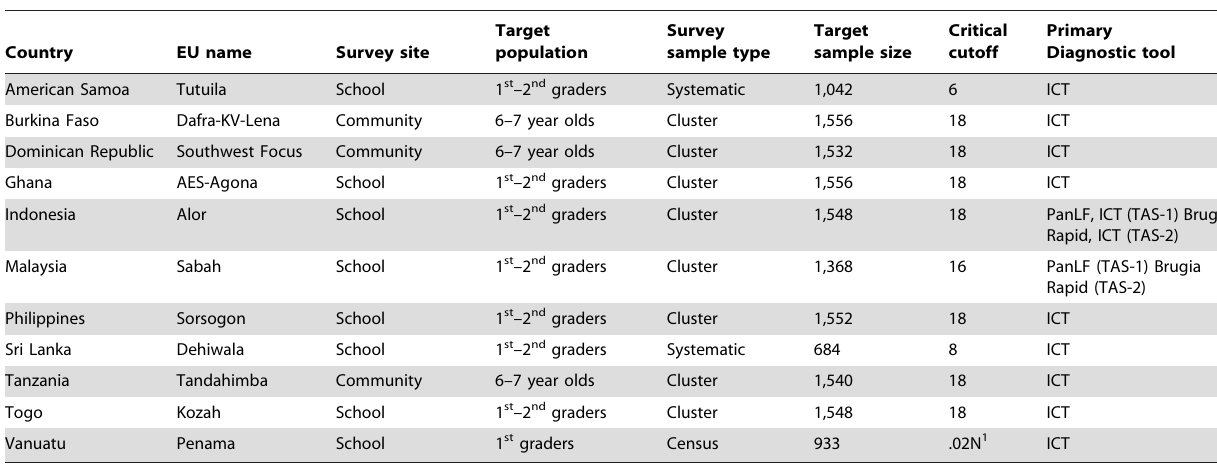
Table 2. Survey design summary for TAS-1 and